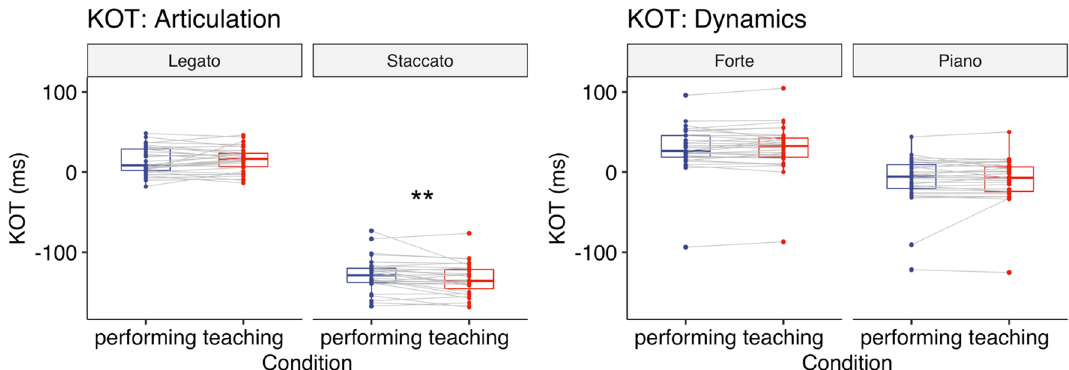
Figure 3. Experiment 1: KOT (ms) when playing the piece with either articulation (left) or dynamics (right). Each box indicates the IQR with the median, and whiskers extend to a maximum of 1.5 × IQR beyond the box. Significance levels: * < 0.05, ** < 0.01, *** <